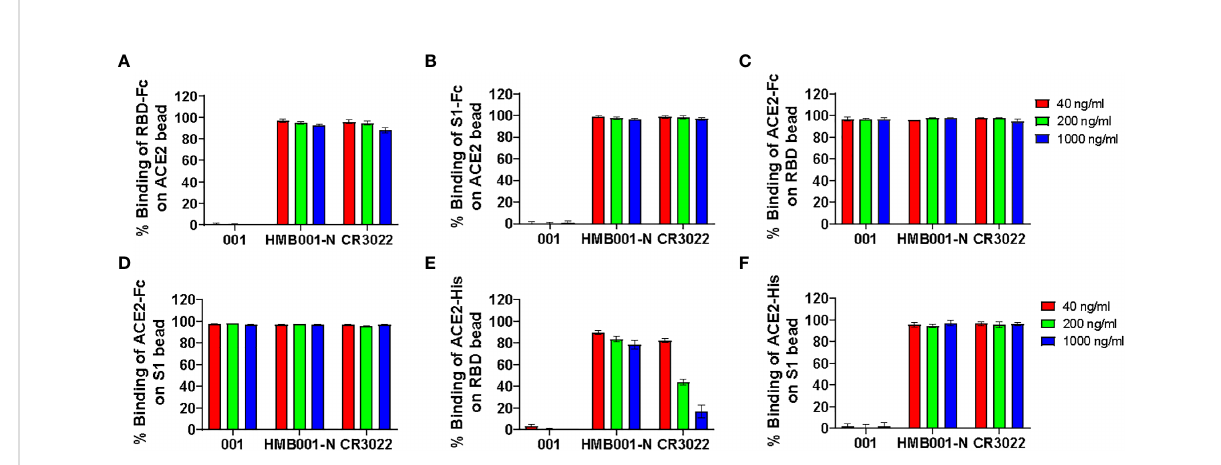
FIGURE 2 Detection of three function-known spike RBD antibodies by the six BFNT models. Two SARS-CoV-2 non-neutralizing mAbs (HMB001-N and CR3022) and one SARS-CoV-2 neutralizing mAb (001) were employed to assess speci fi city and sensitivity of the six BFNT models. Ef fi cacies of binding inhibition of the RBD-Fc on the ACE2 bead, the S1-Fc on the ACE2 bead, the ACE2-Fc on RBD bead, the ACE2-Fc on the S1 bead, the ACE2-His on the RBD bead and the ACE2-His on the S1 bead by the three mAbs at concentrations of 40, 200 and 1000 ng/ml were shown in (A) iACE2/RBD-Fc model, (B) iACE2/S1-Fc model, (C) iRBD/ACE2-Fc model, (D) iS1/ACE2-Fc model, (E) iRBD/ACE2-His model and (F) iS1/ACE2- His model,